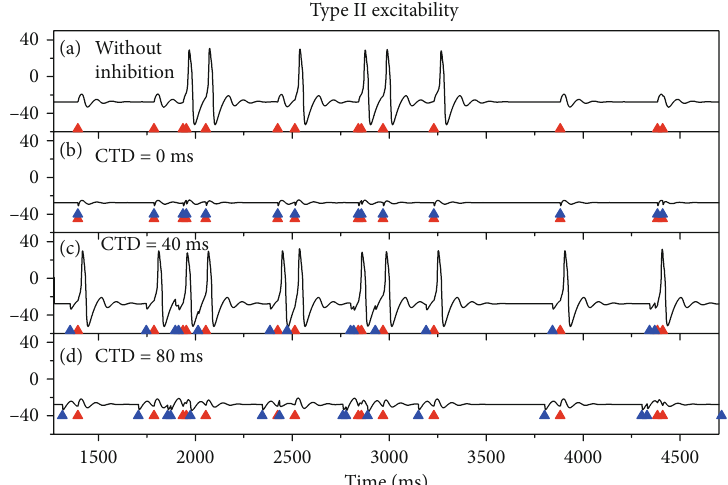
= 1 : 1 mS/cm 2 ). (a) Action ex